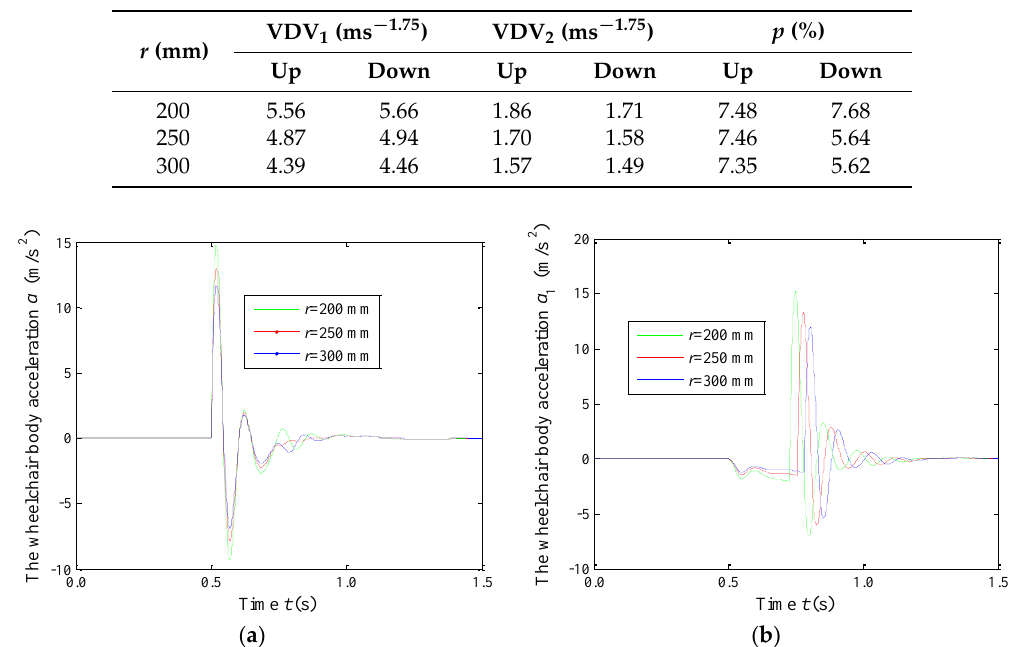
Figure 10. A comparison of the time histories of the wheelchair body acceleration a 1 at different values of r for the wheelchair: ( a ) going up the step; ( b ) going down the step.